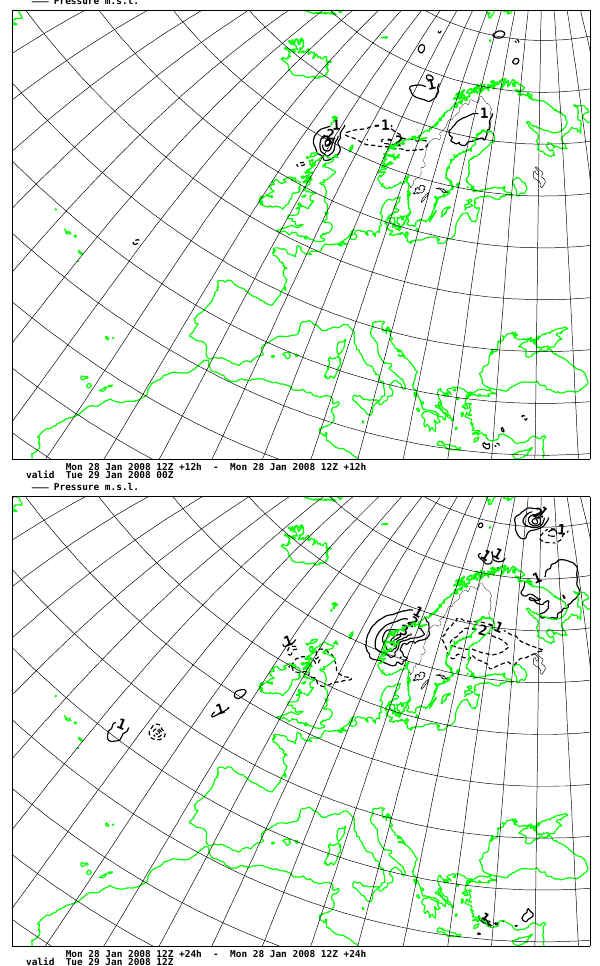
Fig. 13. Differences between mean sea level pressure forecasts from the 4dvar_hybrid1 and the 4dvar_hybrid2 experiments. 27 Jan- uary 2008 + 12h (top panel) and + 24h (bottom panel). The differ- ence between the two experiments is that 4dvar_hybrid2 uses an additional valid time lagged ( + 2h) ensemble in the 4D-Var hybrid ensemble covariance. Isoline spacing 1hPa.